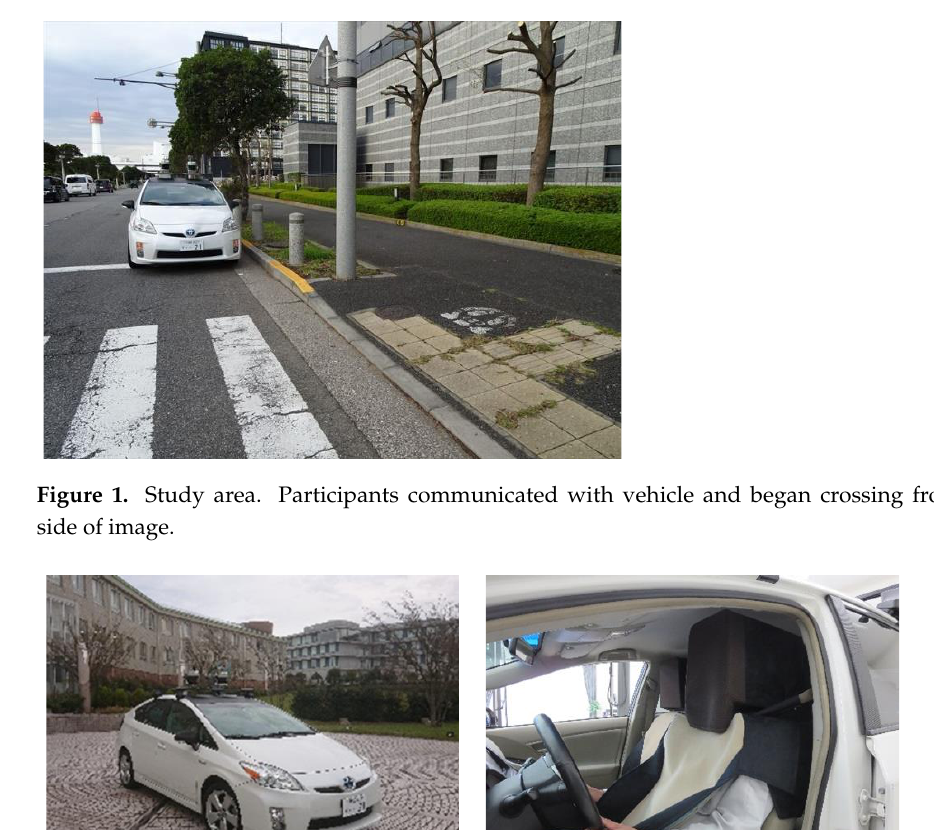
Figure 1. Study area. Participants communicated with vehicle and began crossing from right side of image.